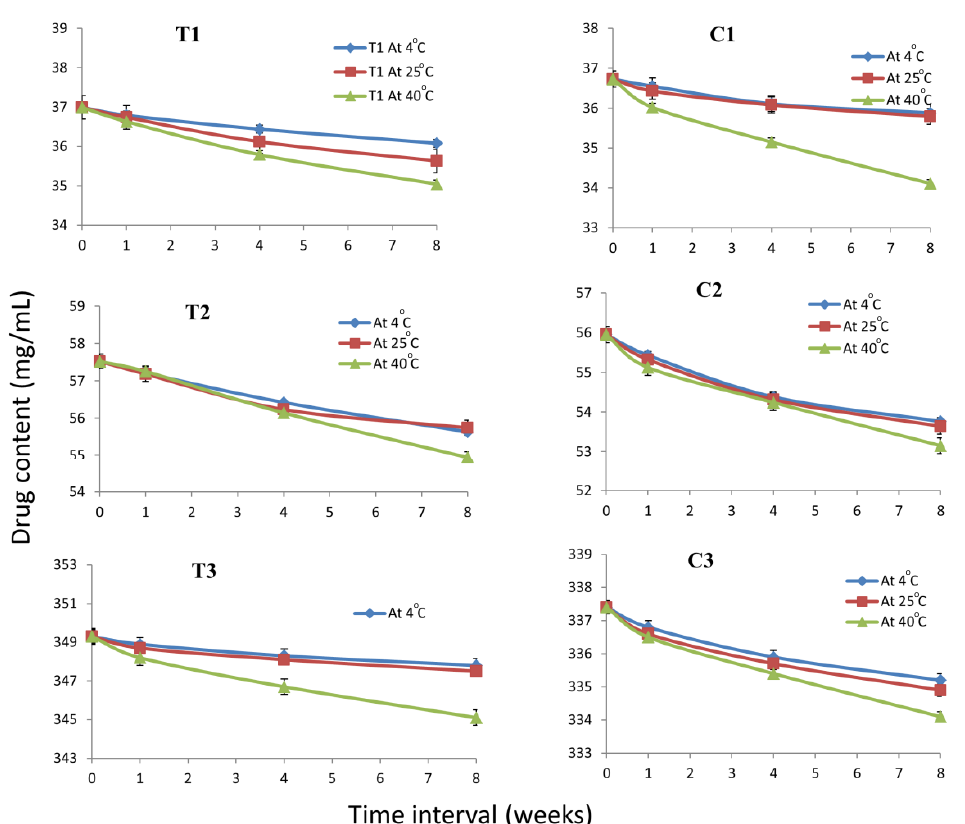
Figure 5. Drug content of microemulsion formulations after 8 week storage at various temperatures. Mean ± SD, n=3.